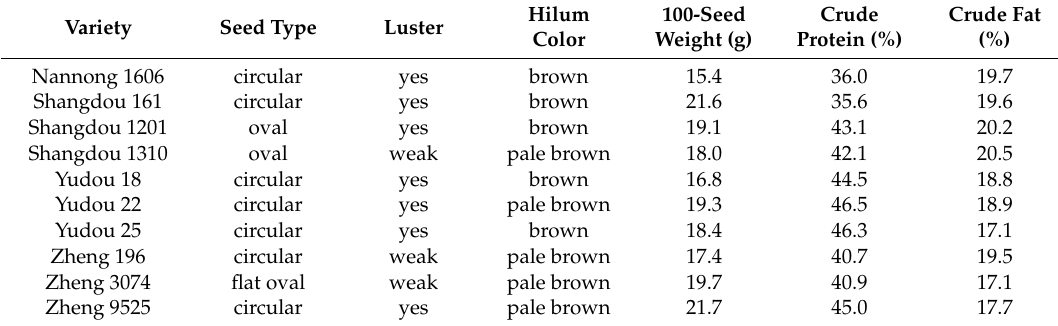
Table 1. Soybean seed quality.